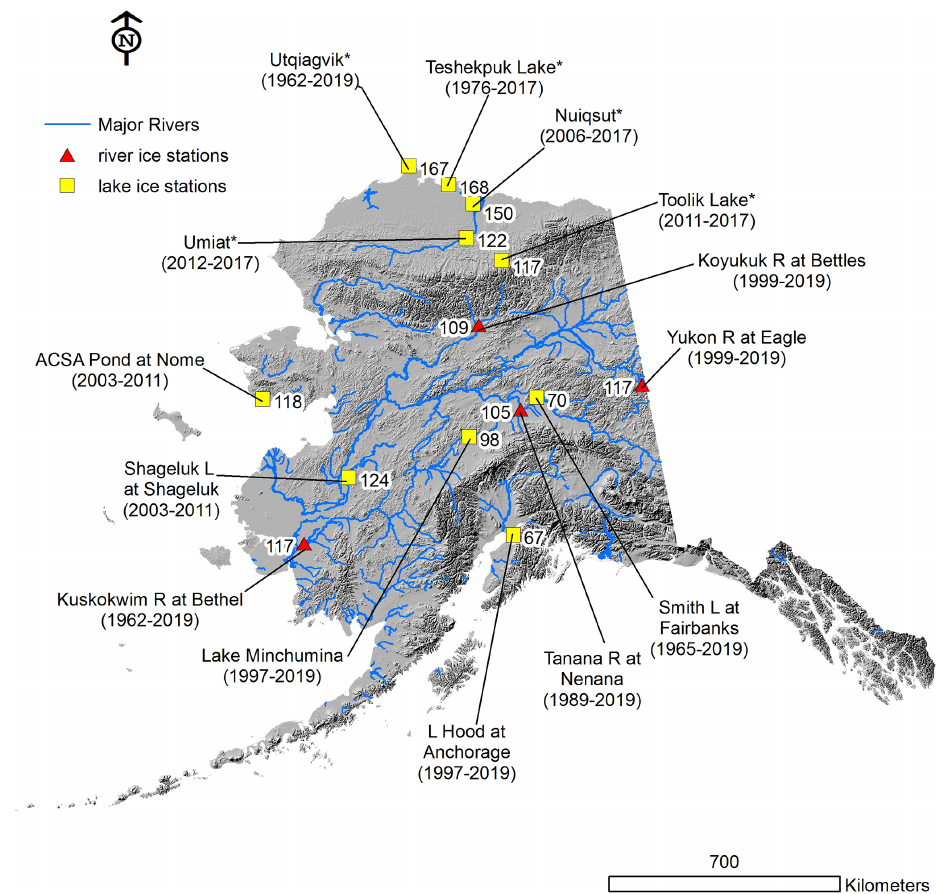
Figure 1. Map of the State of Alaska with all observation locations by water body and nearest community indicated as well as average maximum ice thickness (cm) for each period of record (in parenthesis). Several shorter-term records ( < 20 years) which are not presented in the main analysis are shown here for additional context (* indicates that observations are based on multiple lakes or rivers within a region; 300m digital elevation model hillshade is USGS data in the US public domain).